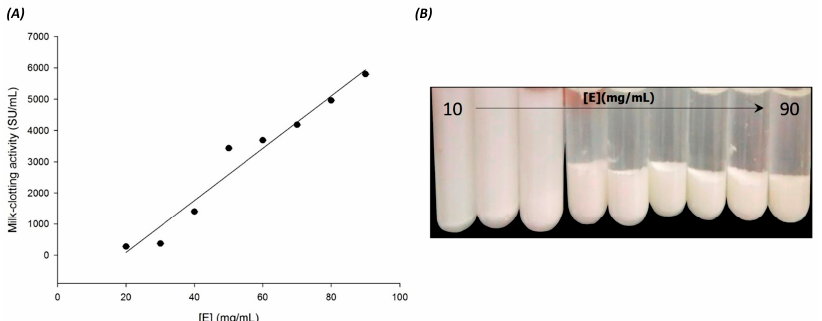
Figure 4. Enzyme concentration effect on skimmed milk-clotting activity of seed extract. ( A ): Left plot was drawn using the data obtained from the milk-clotting activity assay. ( B ): Right image shows the curd formation in test tubes. One unit of milk-clotting activity (MCA) is defined as the amount of enzyme to clot 1 mL of a solution containing 0.1 g skim milk powder in 40 min at 35 °C. Enzyme concentration is expressed as [E]. All experiments were performed in triplicate, and each data point represents the means of at least three determinations. The regression line equation is (y = 83.55x + ( − 1582.85)) with a correlation coefficient of R = 0.98.